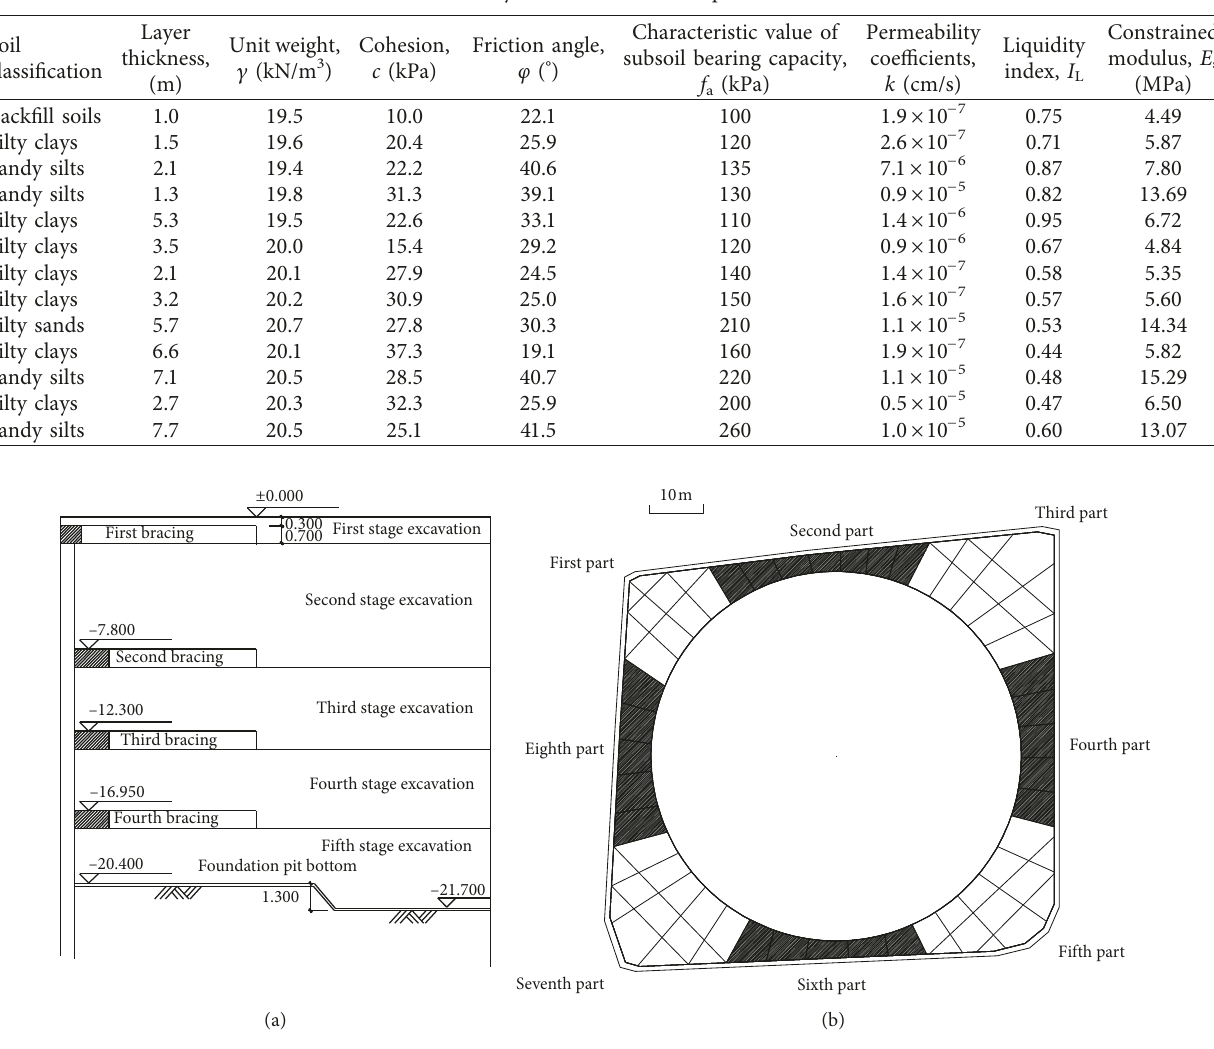
Figure 2: Sketch of the bracing and retaining structure (unit: m). (a) Profile view. (b) Plane